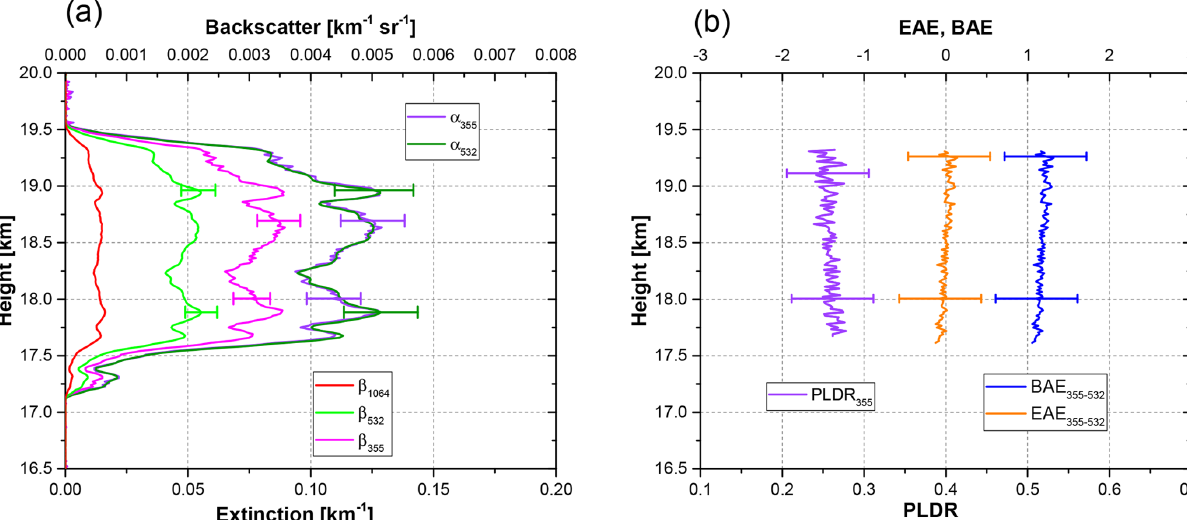
Figure 10. (a) Extinction and backscatter coefficients, (b) the particle linear depolarization ratio (PLDR) at 355nm, and the extinction-related Ångström exponent (EAE) and backscatter-related Ångström exponent (BAE) (between 355 and 532nm) retrieved from IPRAL observations between 19:20 and 21:20UTC on 28 August 2017 in Palaiseau. Table 3. Retrieved microphysical properties using the lidar data in Lille and Palaiseau. Extinction and backscatter coefficients shown in Figs. 9a and 10a are averaged in the range of 17–18.0 and 17.5–19.5km, respectively. The averaged extinction and backscatter coefficients are used as the input of the regularization algorithm to retrieve particle microphysical properties. R eff (µm)